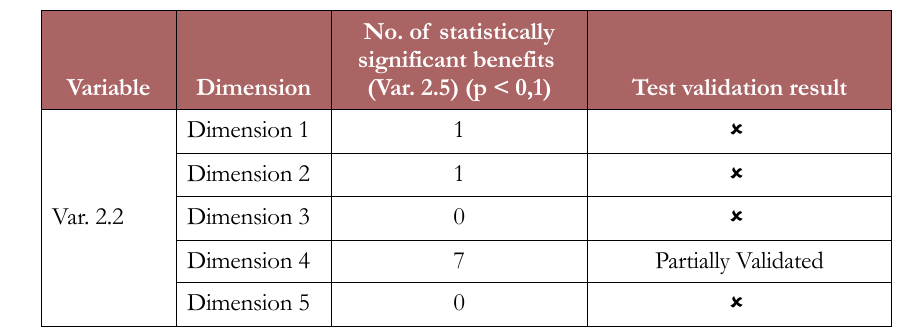
Table 3. Asym. Sig. (Kruskal-Wallis test)